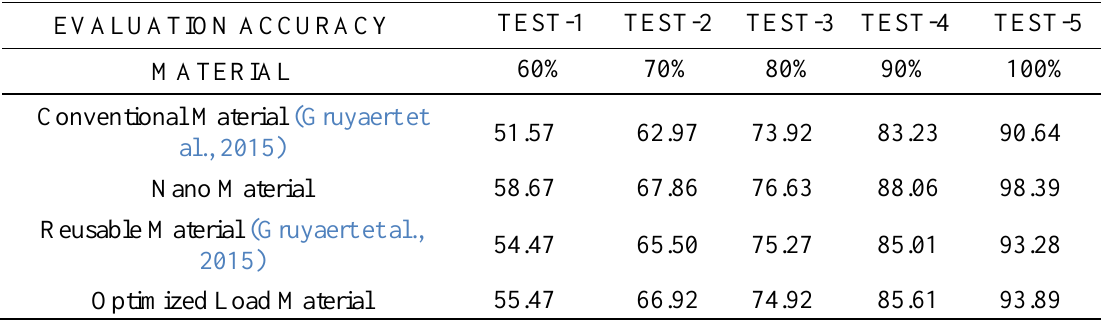
Table 1. Evaluation of different construction material being used in the self-healing architectural buildings (Tam, V.W.Y. and Tam, C.M., 2016)